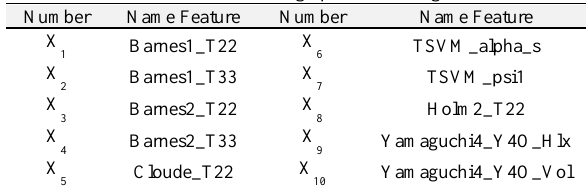
Table 7. Selected features using optimization algorithms SBS